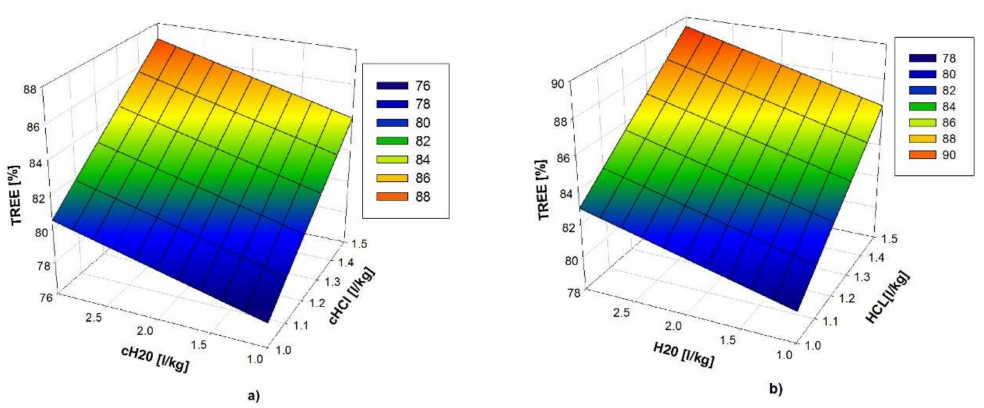
Figure 7. TREE eff. = f ( c HCl, c H 2 O) for ( a ) T = const. = 20 ◦ C, t = const. = 20 min.; and, ( b ) T = const. = 20 ◦ C, t = const. = 60